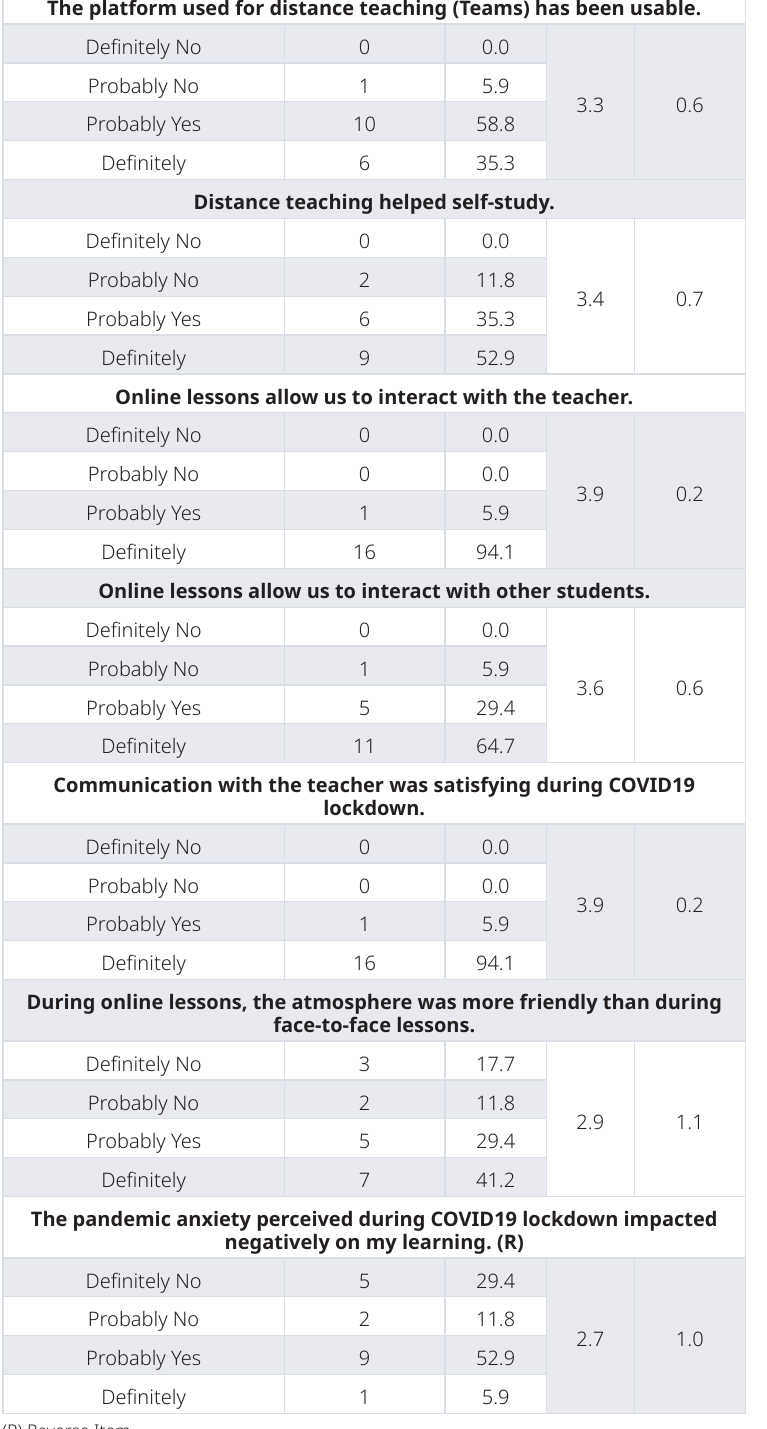
Table 3. Perceptions about distance learning.